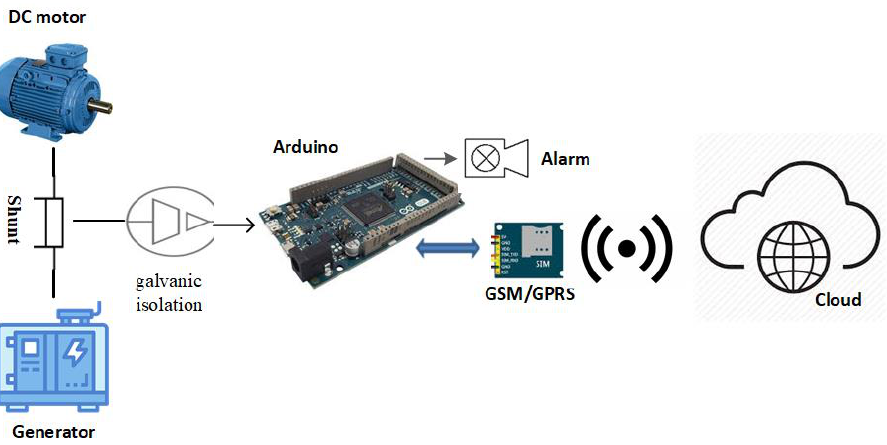
Figure 3. Block diagram of the proposed solution.